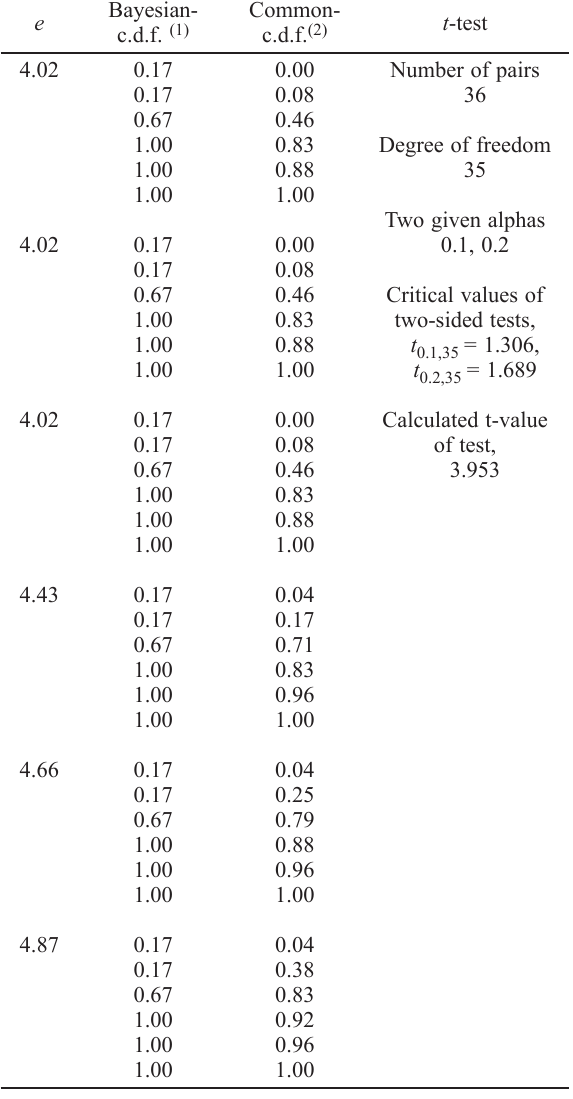
Table 4. Hypothesis test summary